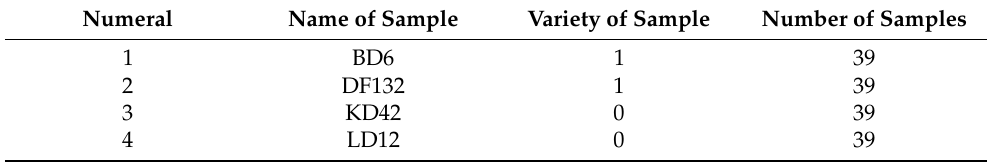
Table 2. Variety and quantity of test samples (1: saline–alkali-tolerant; 0: saline–alkali-sensitive). Numeral